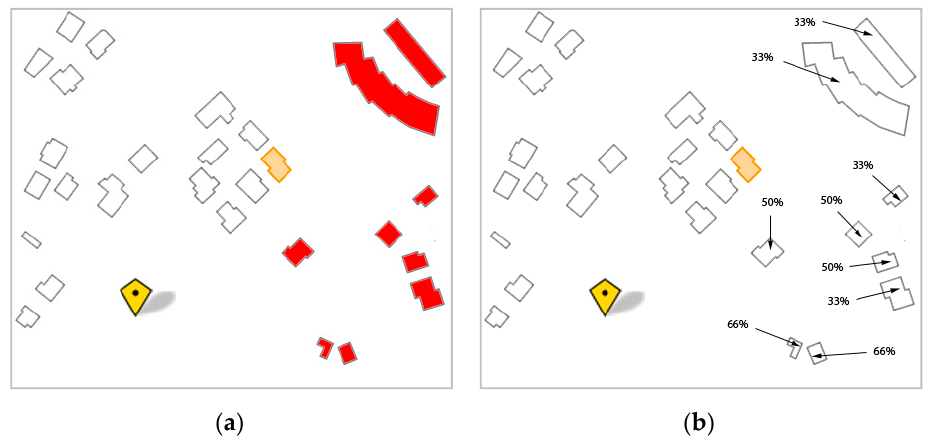
Figure 23 . Results of the right_of relation with respect to the selected building: ( a ) from the application; ( b ) from the user tests.